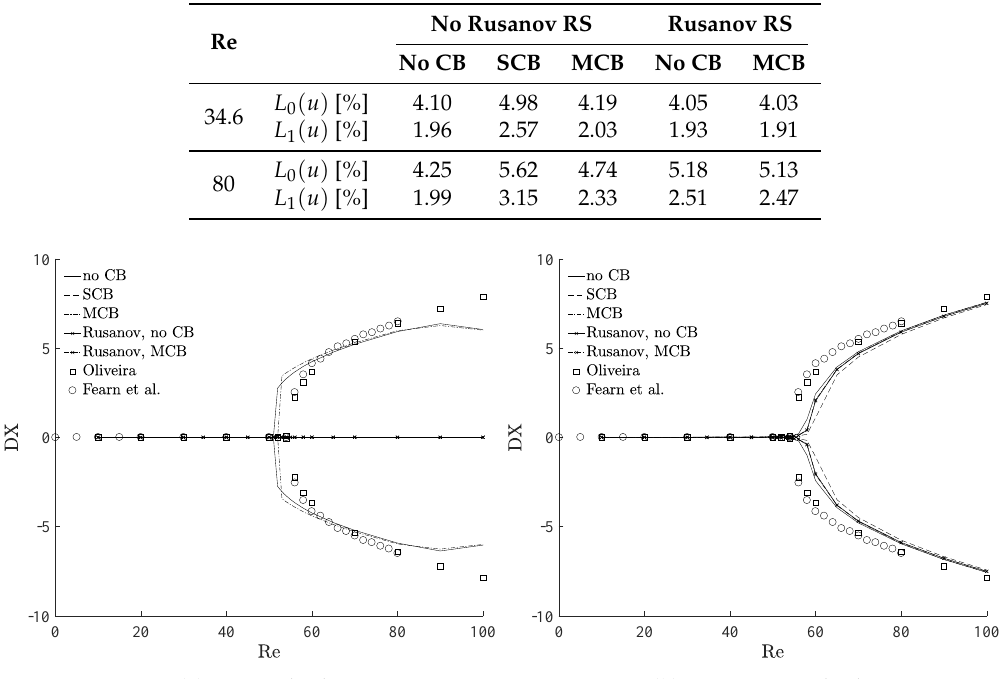
Table 4. L 0 and L 1 error norm of the velocity profiles for the FSAC-PP method using different combinations of CB schemes and the Rusanov Riemann solver at Re = 34.6 and Re = 80.